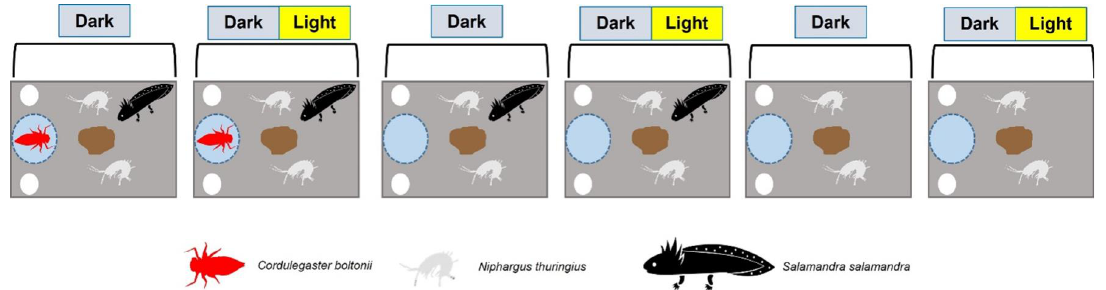
Figure 2. Disposition and composition of the microcosms in the laboratory of Subterranean